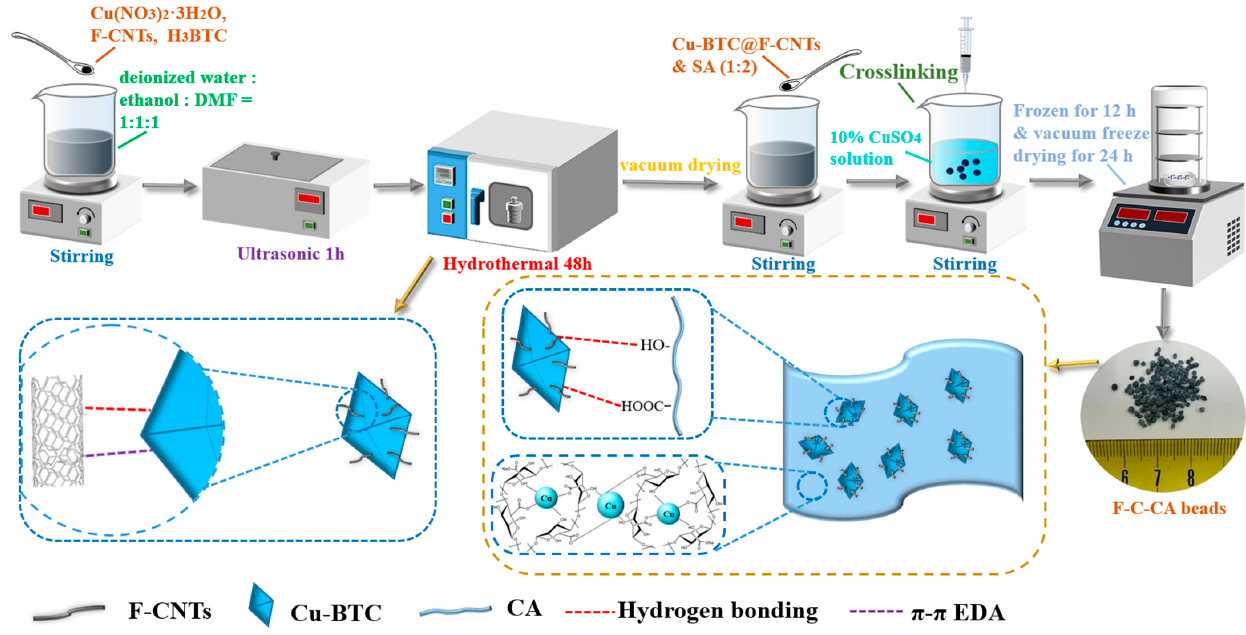
Figure 1. The preparation method of the F-C-CA aerogel